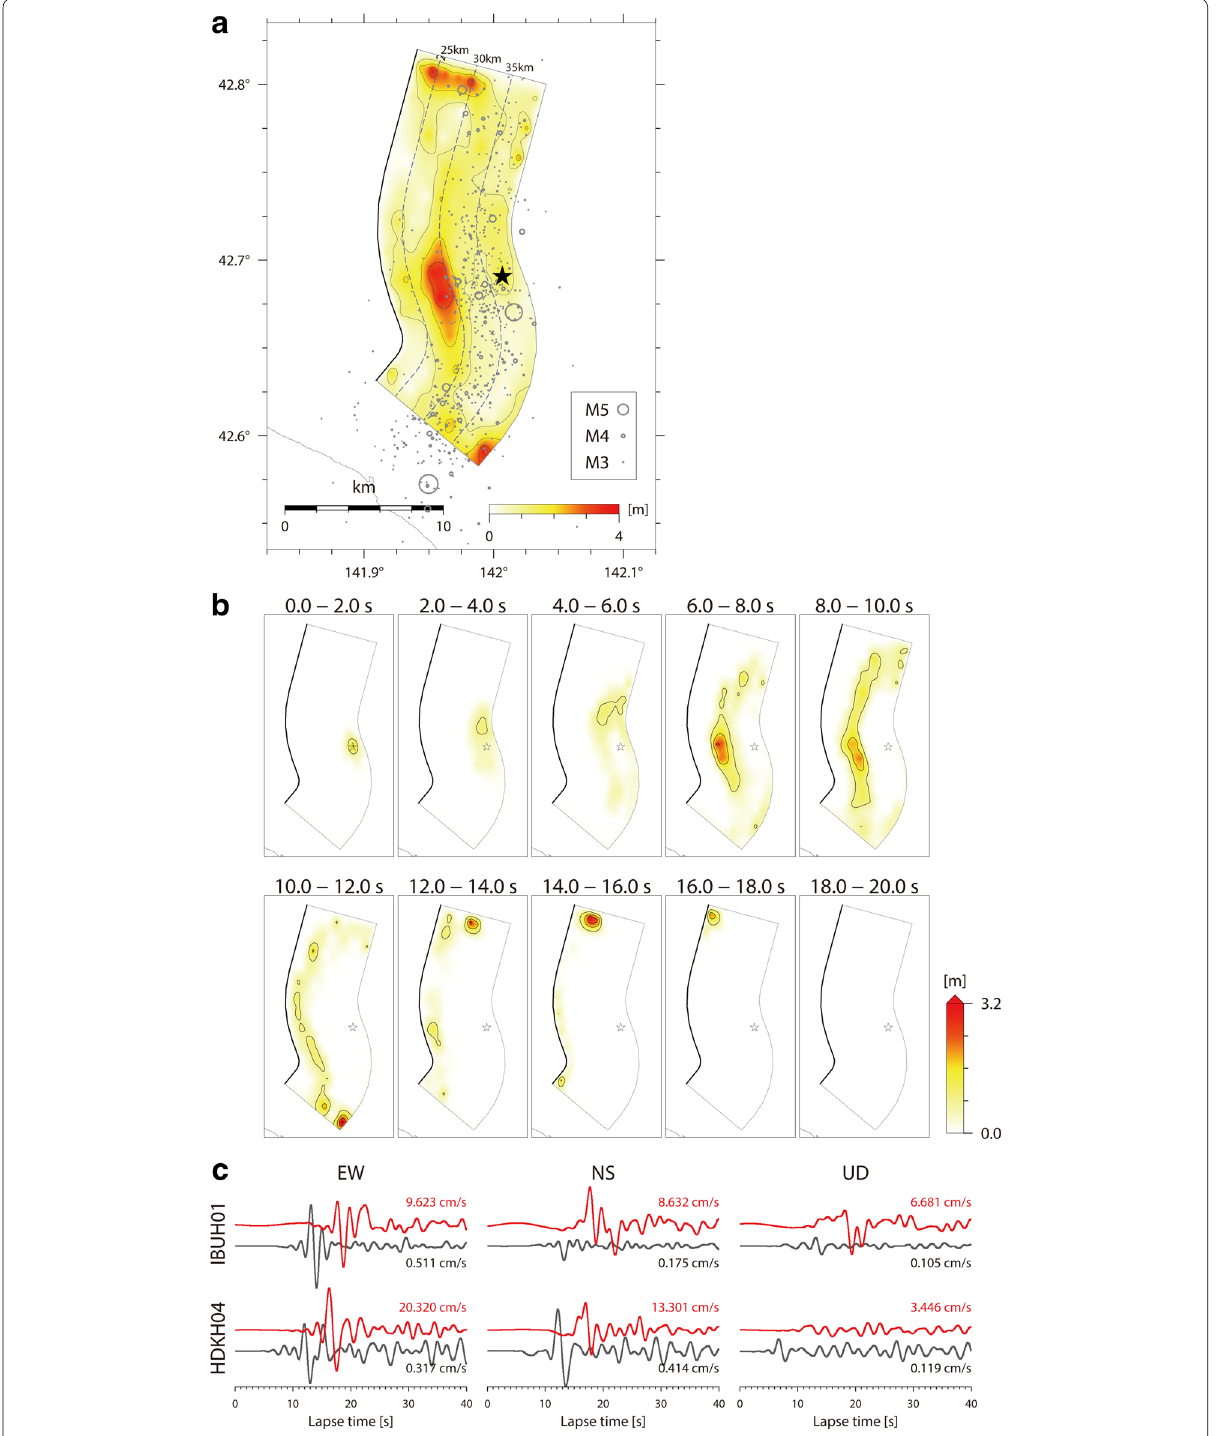
Fig. 2 a Map projection of the total slip distribution. The slip contour interval is 1.0 m. The star denotes the epicenter. Gray circles denote the hypocenters of the aftershocks ( M 1) that occurred within 1 day after the mainshock. The size of the circles indicates the event magnitude. Dotted ≥ lines denote the isodepth contours of the curved fault model at 5 km intervals. b Rupture progression in terms of slip amount for each 2.0 s interval. The slip contour interval is 0.8 m. c Comparison of observed waveforms in the mainshock (red) and the M JMA 5.4 aftershock (black) at HDKH04 and IBUH01. These waveforms, which were observed on the ground surface, are low-pass filtered at 0.5